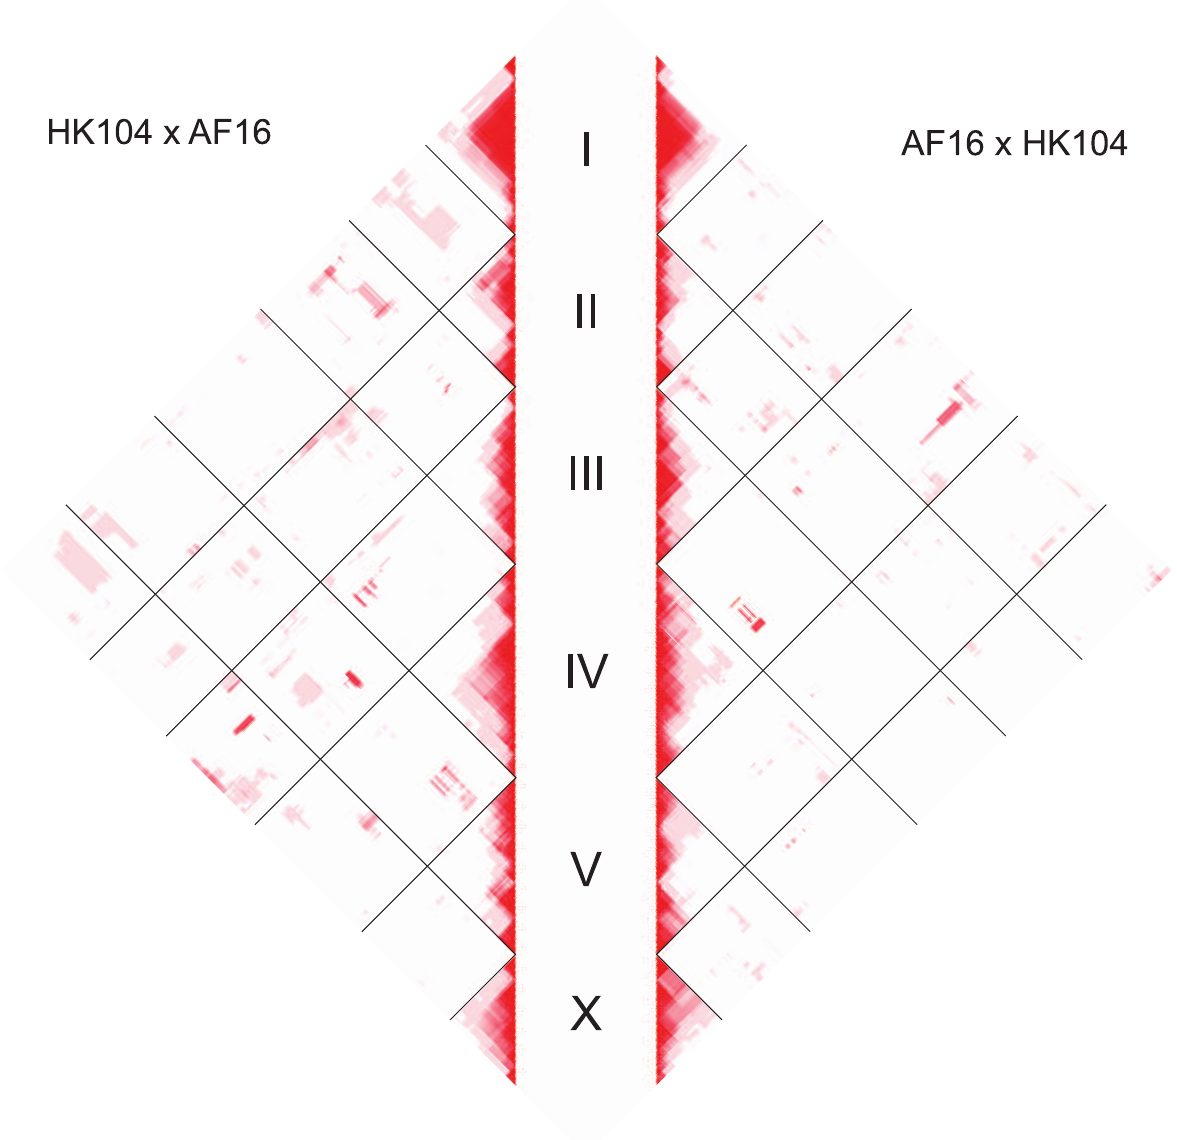
Figure 6. Genome-wide linkage disequilibrium by cross direction. The left panel shows LD values for the HK104 6 AF16 AI-RIL; the right panel shows LD for the AF16 6 HK104 AI-RIL. Linkage disequilibrium (D 9 ) values for each pairwise comparison of markers were calculated and plotted. Marker spacing on the y axis is not scaled by physical or genetic distance; each marker occupies one unit space. Red indicates D 9 =1; shades of red indicate decreasing D 9 values approaching 0